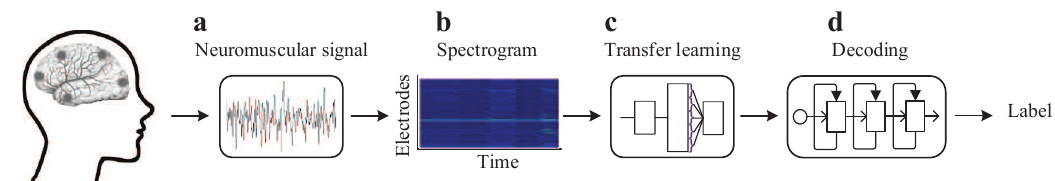
Figure 4. Silent speech decoding. ( a ): The neuromuscular activities are captured by surface electrodes; ( b ): All data are transformed into spectrograms by short-time Fourier transform (STFT); ( c ): Transfer learning method is used to extract features from spectrograms; ( d ): Neural networks decode multi-channel sEMG using the extracted features.